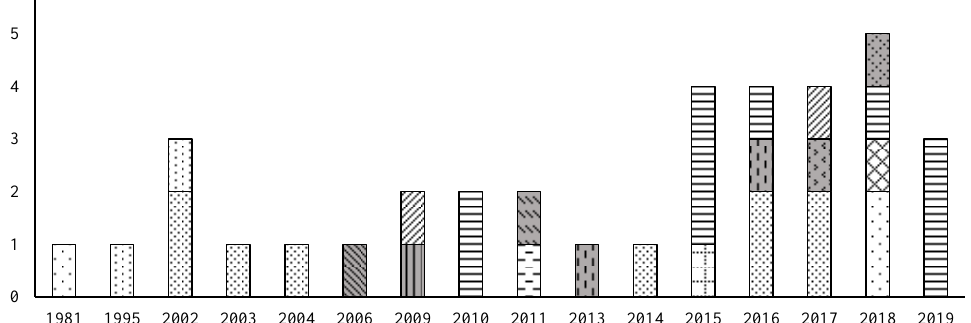
Figure 11. Patents about protection of series compensated lines, by year and